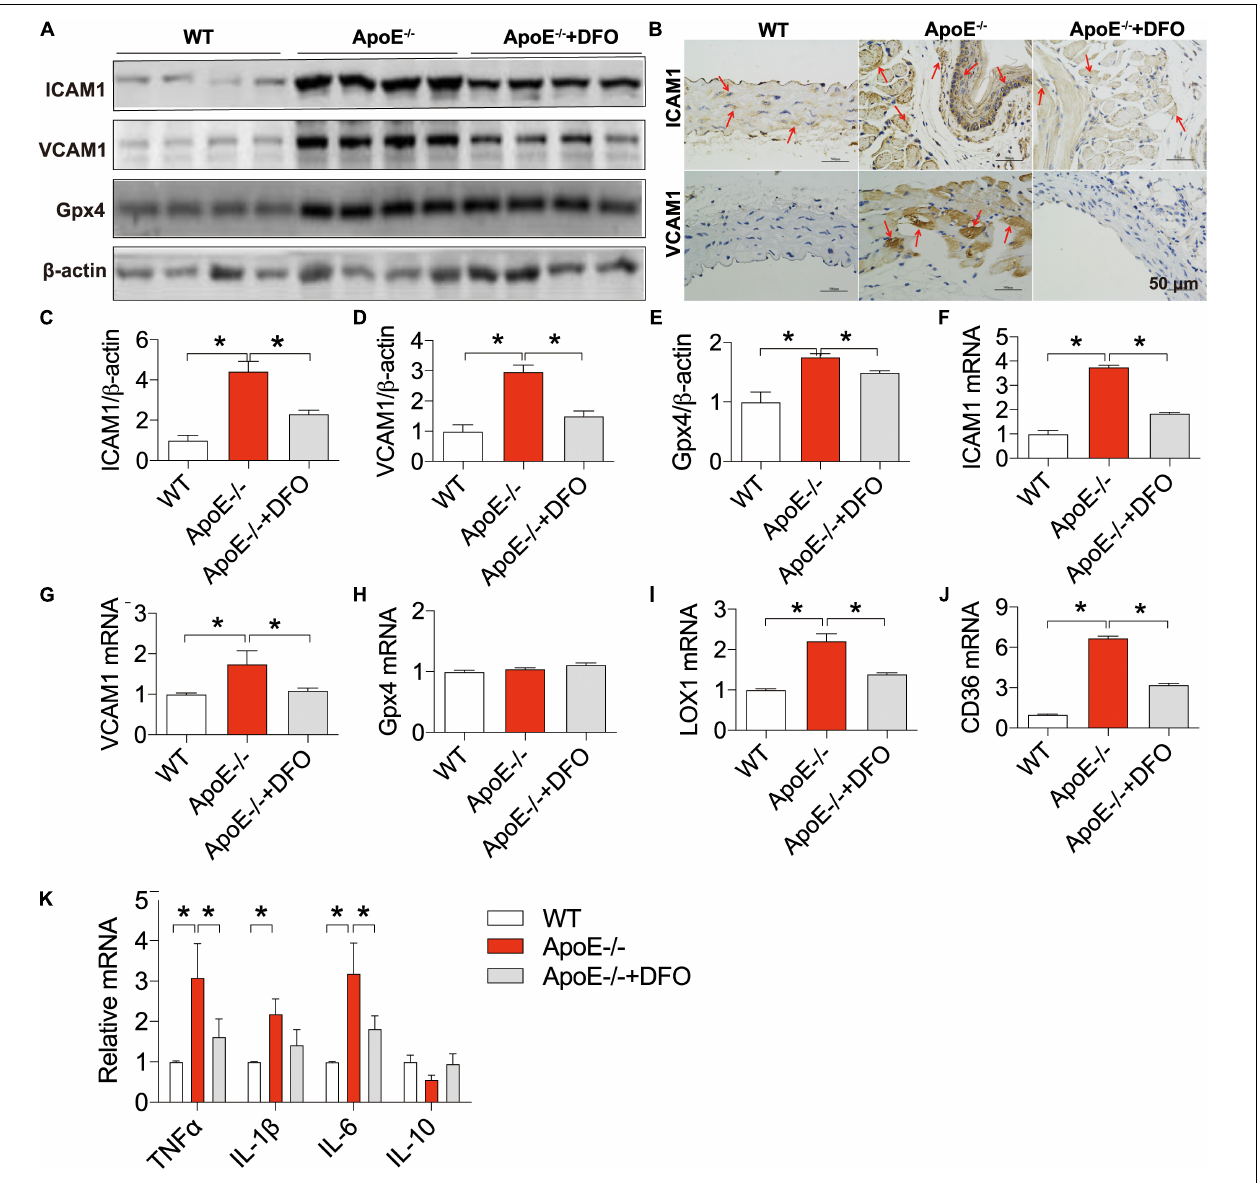
FIGURE 5 | ApoE deficiency up-regulated the expression of ICAM1, VCAM1, LOX-1, CD36, Gpx4, TNF α , IL-1 β , and IL-6 in the aortic tissues of mice. The expression of ICAM1, VCAM1 and Gpx4 proteins in the aortic tissues were measured by Western blot [ICAM1, (A,C) ; VCAM1, (A,D) ; Gpx4, (A,E) ] or/and immunohistochemistry [ICAM1, (B) ] analysis, and ICAM1 (F) , VCAM1 (G) , Gpx4 (H) , LOX-1 (I) , CD36 (J) , and inflammatory cytokines TNF α , IL-1 β , IL-6 and IL-10 (K) mRNAs by RT-PCR analysis as described in section “Materials and Methods” in WT ( n = 6; WB: n = 4), ApoE – / – ( n = 6; WB: n = 4) and ApoE – / – + DFO ( n = 6; WB: n = 4) mice, all aged 28 week-old. The mice in ApoE – / – + DFO group received daily i.p. injections of 100 mg/kg body weight (b.w.) of DFO in HBSS for 14 days. Scale bar in panel (B) = 50 µ m. Data are presented as the mean ± SEM. * p <